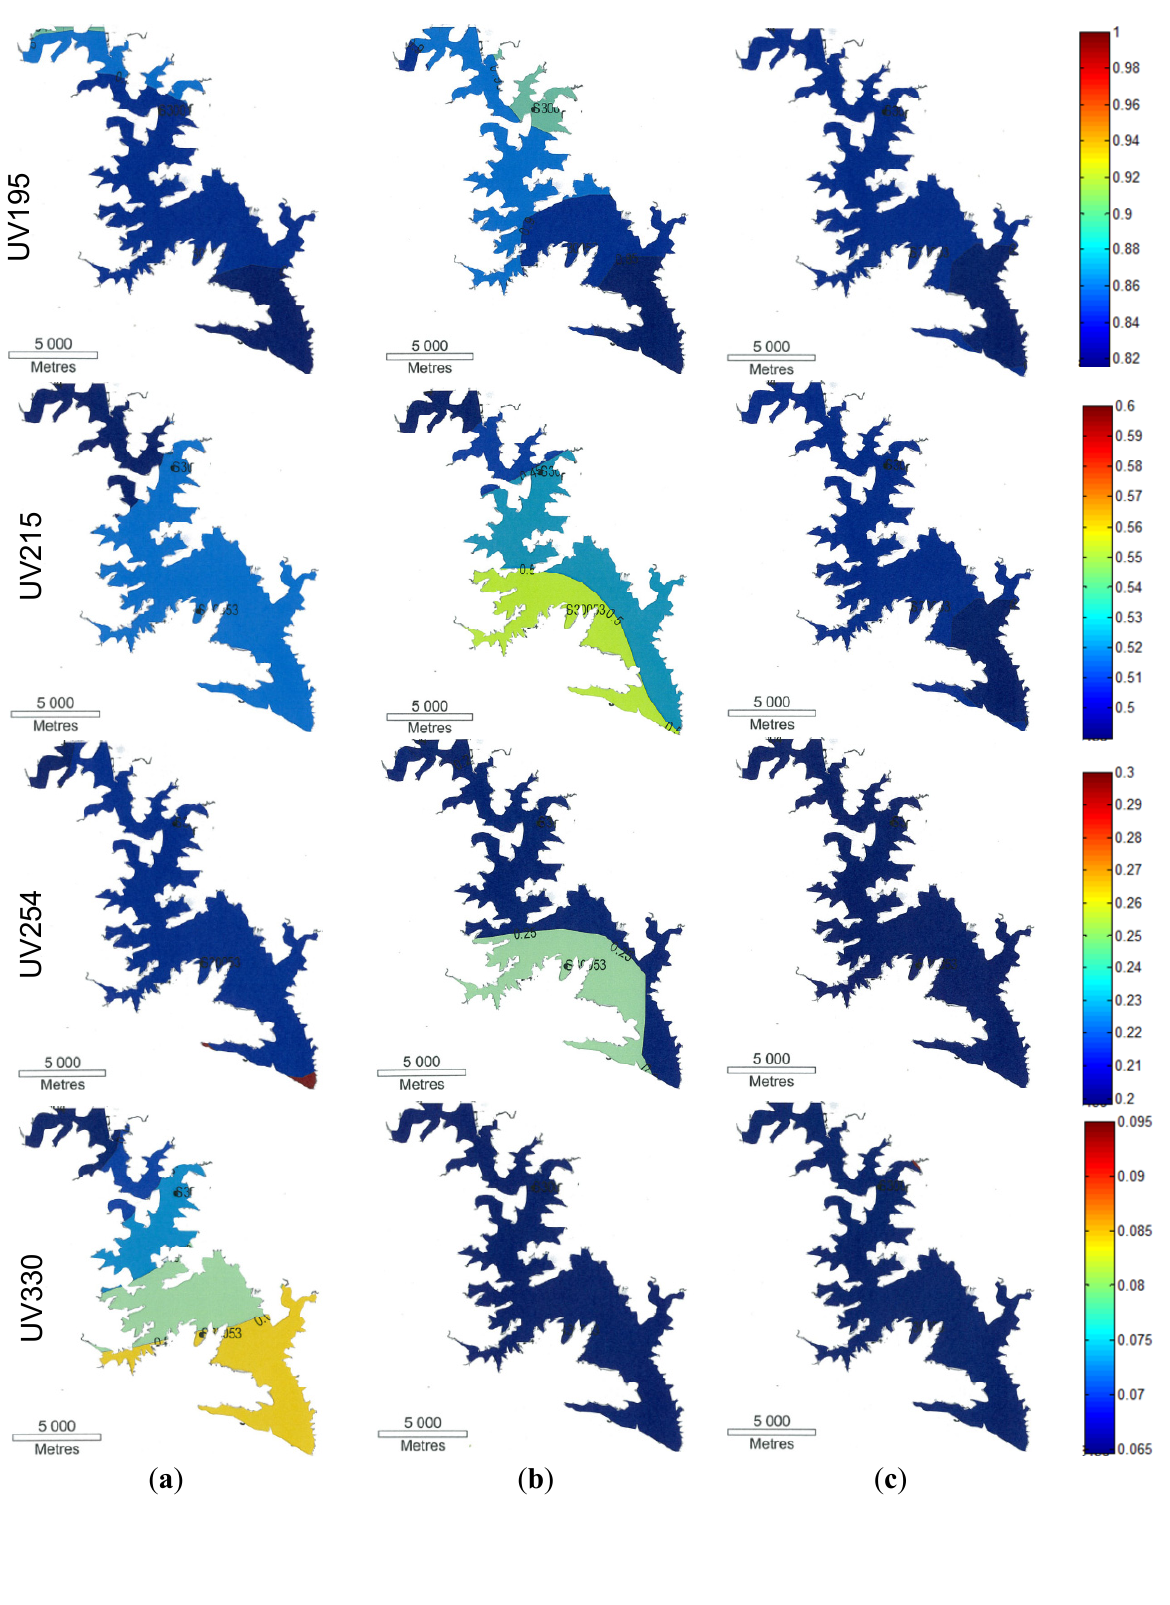
Figure 3. Contour diagram of the UV spectral intensity of flood water recorded at wavelengths 195, 215, 254 and 330 nm collected at the surface ( a ), mid-depth ( b ) and bottom ( c ) of Lake Wivenhoe (colours indicate the absorbance